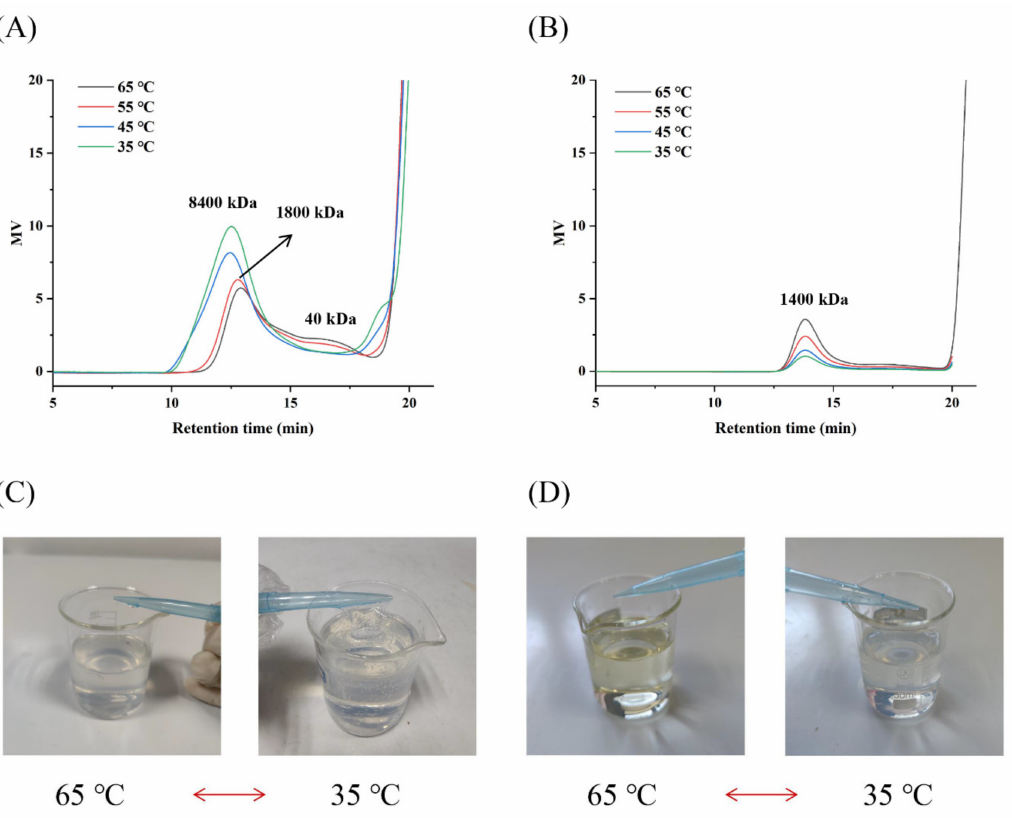
Figure 9. Effect of temperature on the product distribution and solution status of the recombinant LSs. ( A ) Effect of temperature on the product distribution of Cedi-LS. ( B ) Effect of temperature on the product distribution of Psor-LS. ( C ) Effect of temperature on the reaction mixture of Cedi-LS. ( D ) Effect of temperature on the reaction mixture of